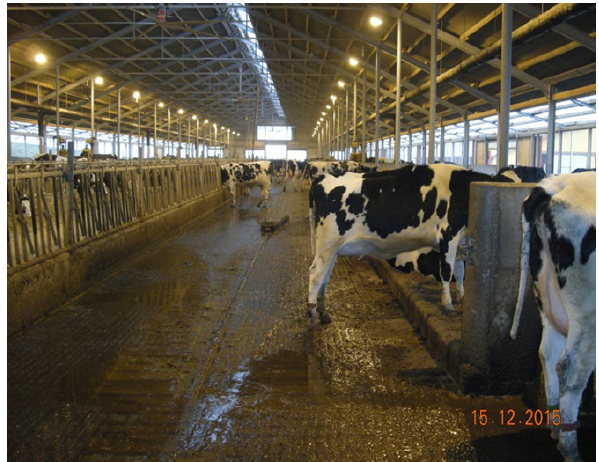
Figure 3. Grooved floor in alleys.